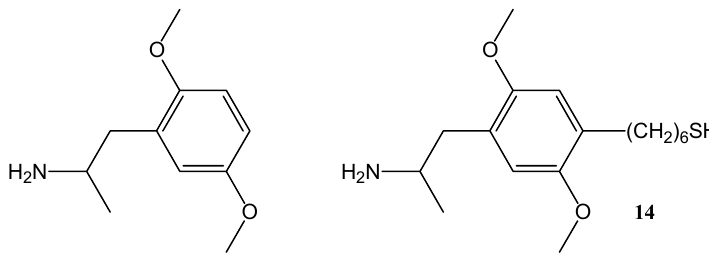
Figure 1. 1-(2-aminopropyl)-2,5-dimethoxybenzene, a known high affinity agonist for 5HT receptors, and the structure of our proposed ligand 14 2A